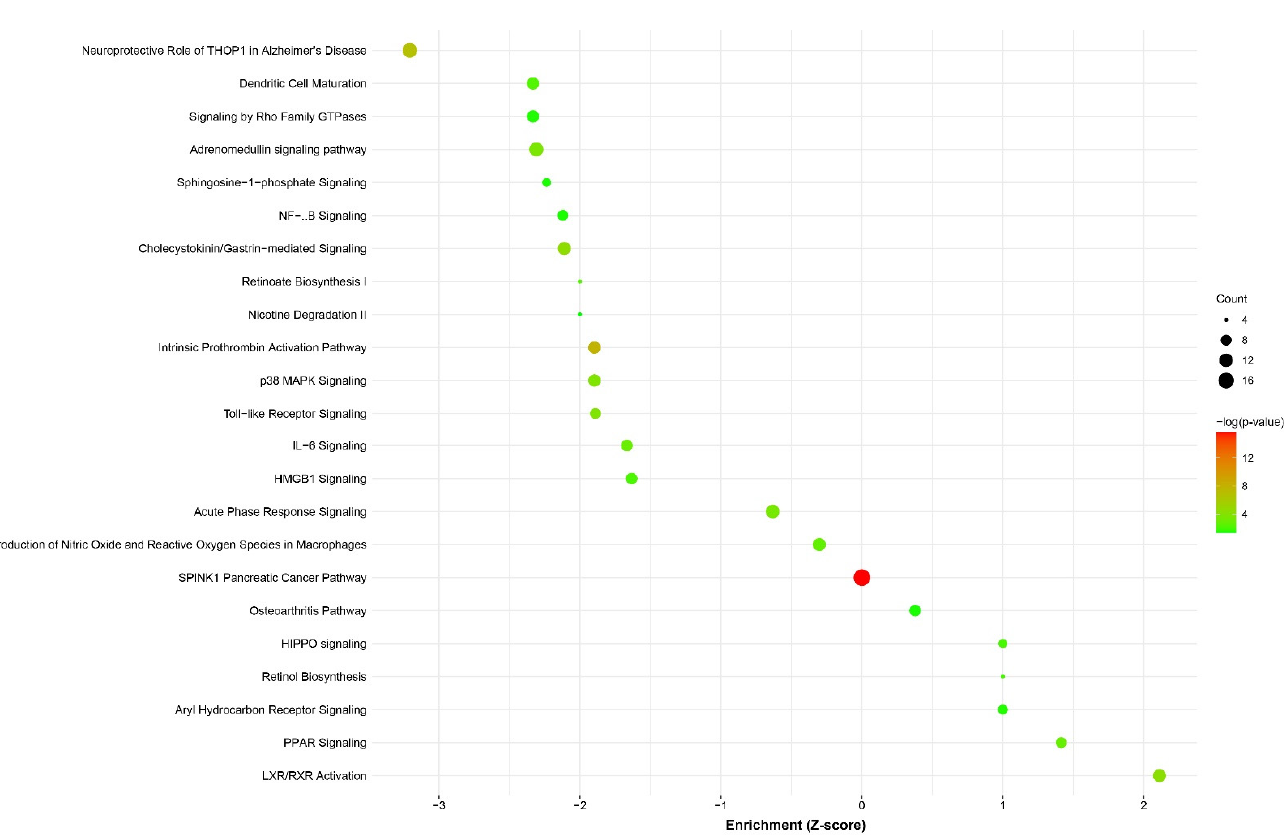
Figure 4. Bubble plot of canonical pathways, significantly enriched by differentially expressed genes, between gastroesophageal junction (GEJ) samples of group A (esophageal atresia (EA) with Barrett’s esophagus (BE)) and GEJ samples of group C (BE-only). The color and size of the dots represent the range of the p -value and the number of molecultes mapped to the indicated pathways. Settings: p -value < 0.05 (= − log( p -value) > 1.3), z-score < − 2 or >2. SPINK1 Pancreatic Cancer Pathway is also the only significantly upregulated pathway, when comparing group A (EA/BE) with group C (BE-only). Plotted by http://www.bioinformatics.com.cn (accessed 2021/11/24), a free online platform for data analysis and visualization.